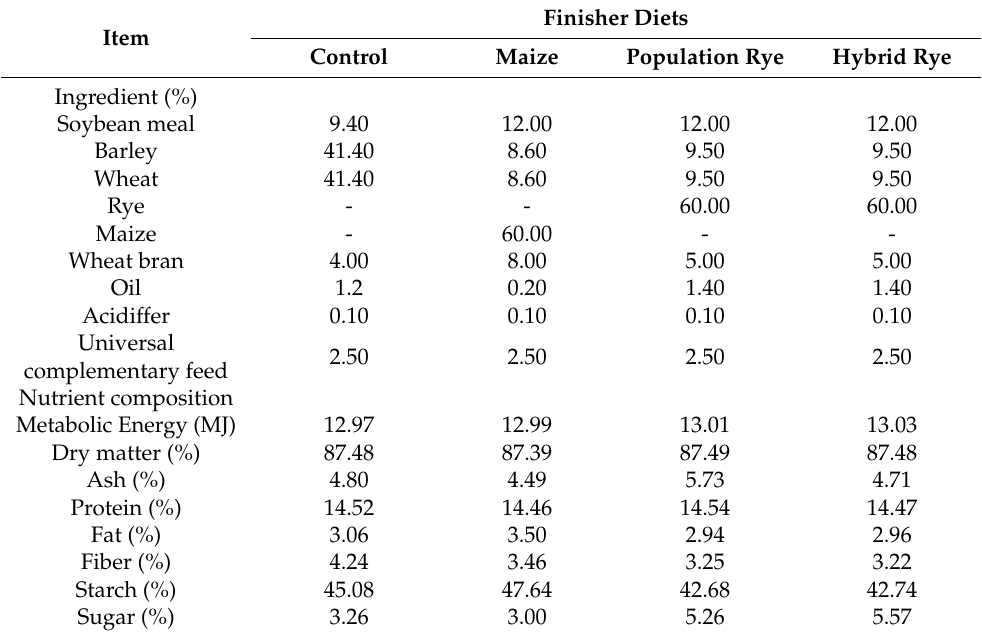
Table 2. Composition of the grower mixtures used in control and experimental groups of pigs during the first 40 days of